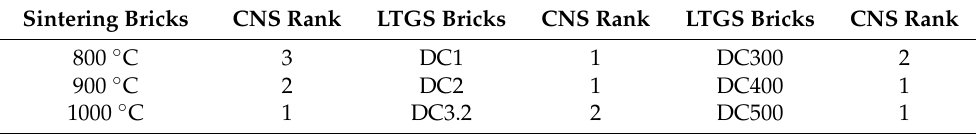
Table 6. Ranking of building bricks made with high temperature sintering method and LTGS